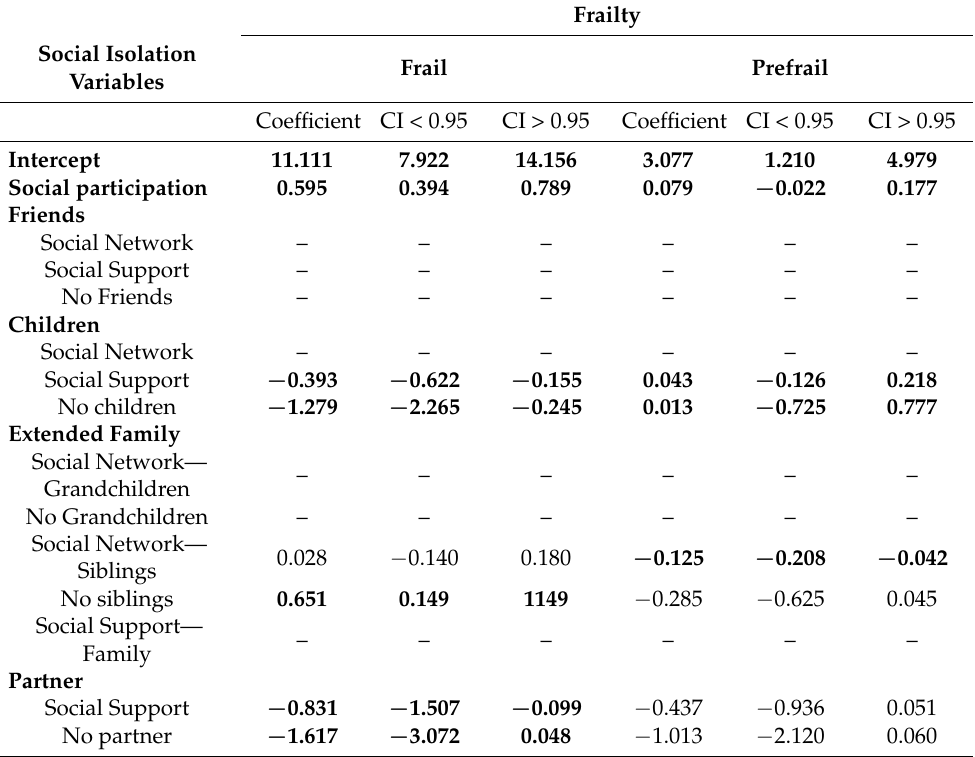
Table 2. Logistic regression of social isolation on